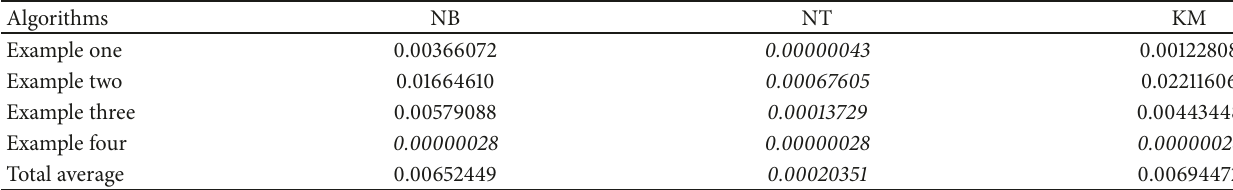
Table 2: Mean relative errors |𝑦 𝑖 − 𝑦 ∗ 𝑖 |/|𝑦 ∗ 𝑖 | (𝑖 = 1,2,3) for the number of sampling points 𝑁 = 50 : 50 : 4000